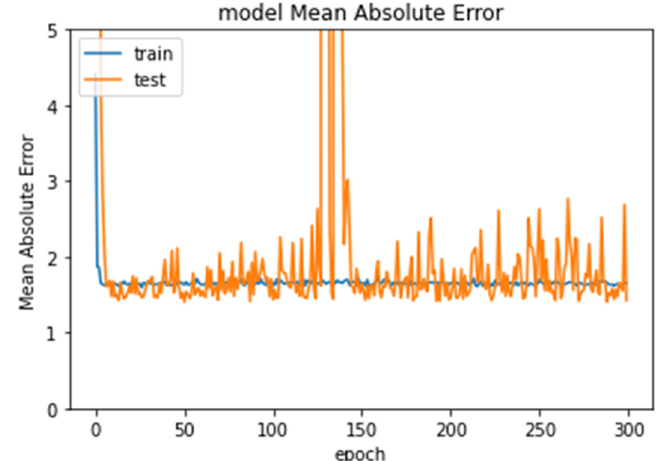
Figure 7. Error rate for Experiment 3 through epochs.